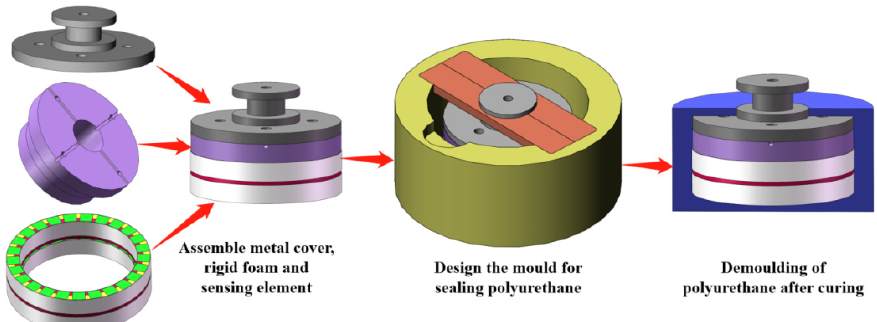
Figure 11. Assembly and the potting of the underwater acoustic transducer.